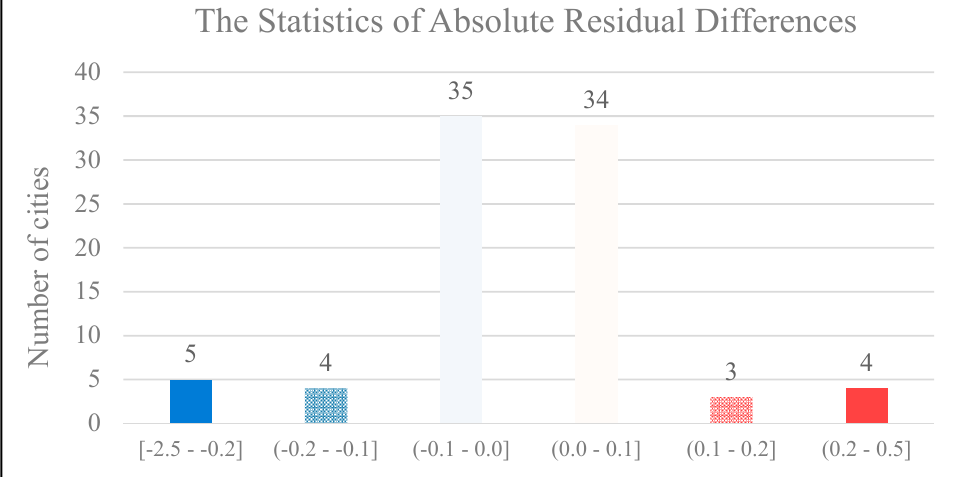
Figure 14. Distribution of 85 Chinese cities’ relative residuals using OSM road network density and population. ISPRS Int. J. Geo-Inf. 2020 , 9 , x FOR PEER REVIEW